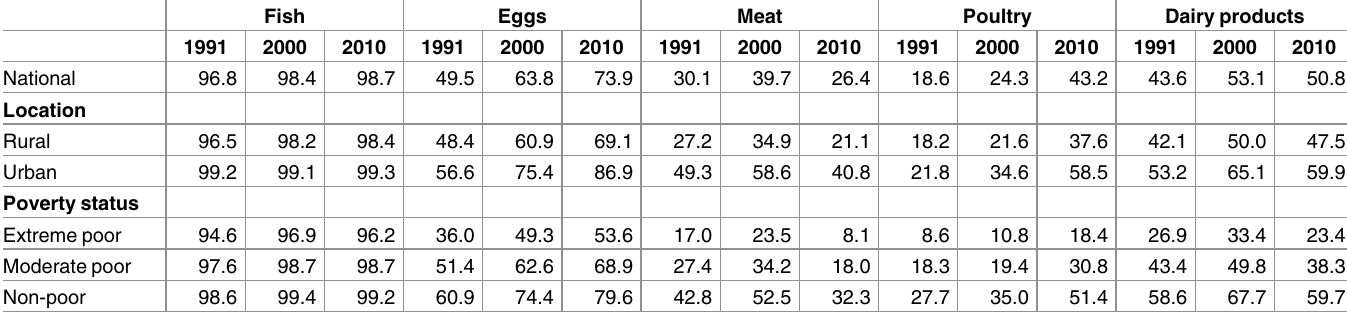
Table 3. Proportion of total households (%) reporting consumption of selectedanimal-source foods in the survey period *